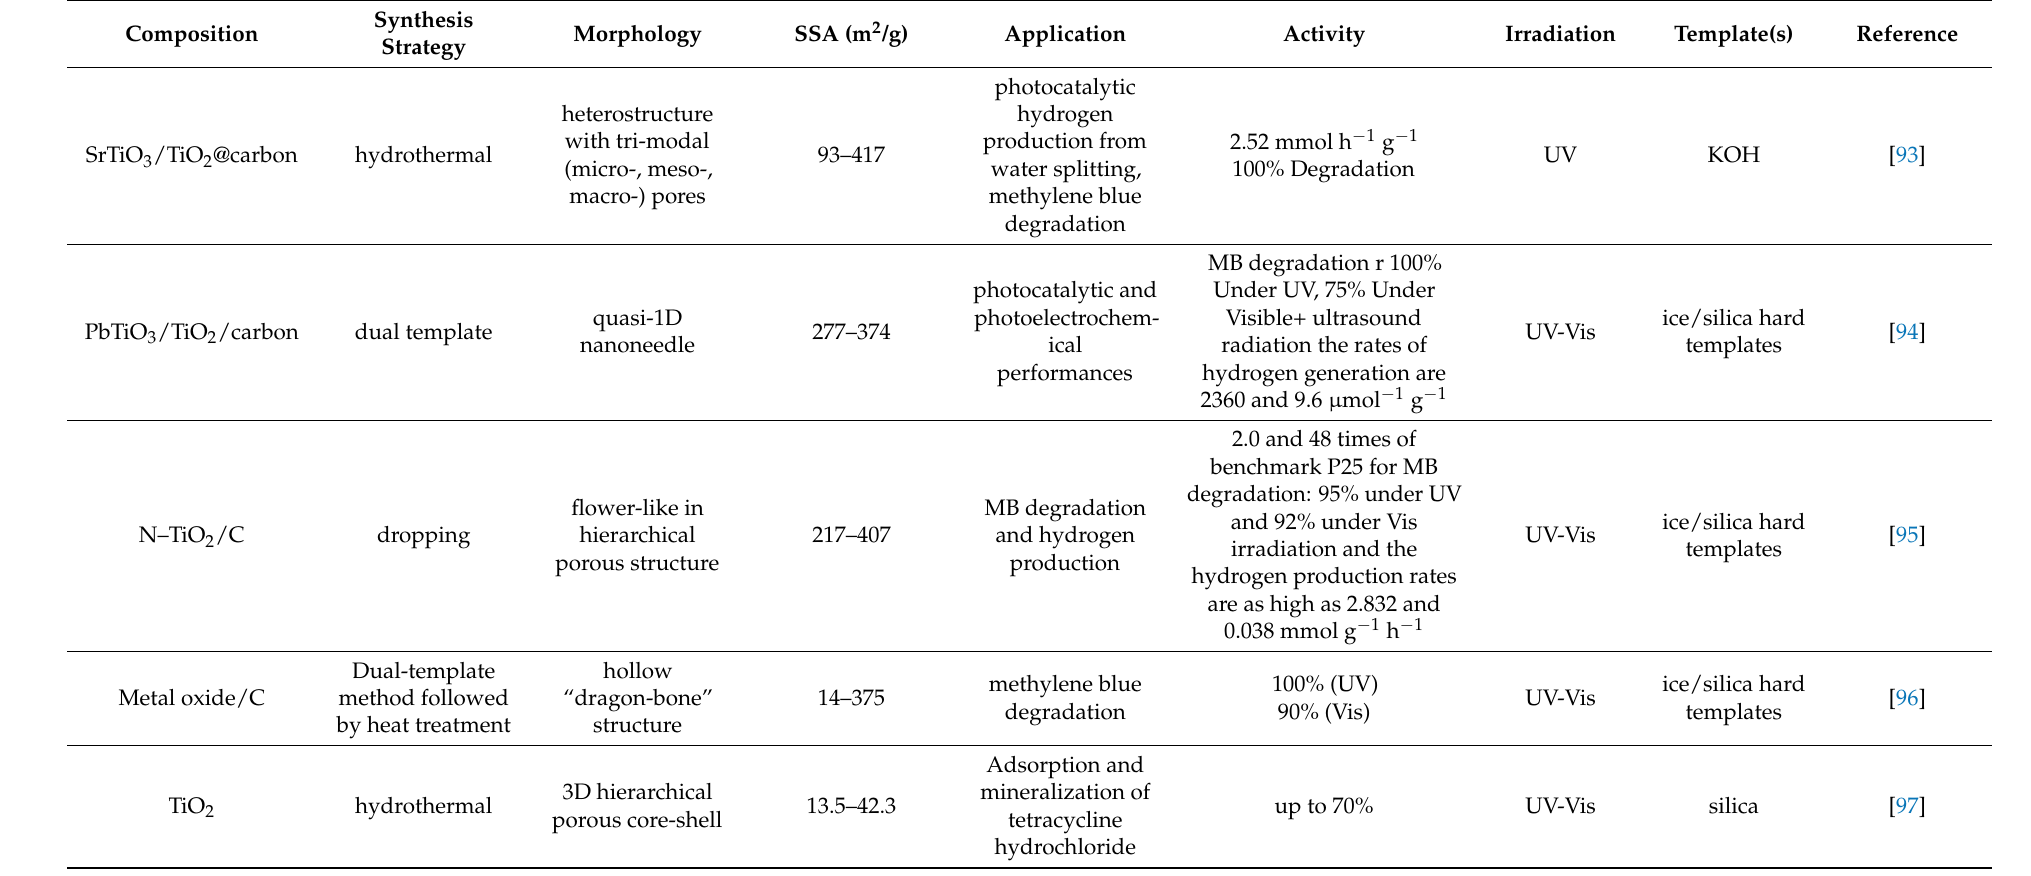
Table 1. Hierarchical catalysts produced by using inorganic